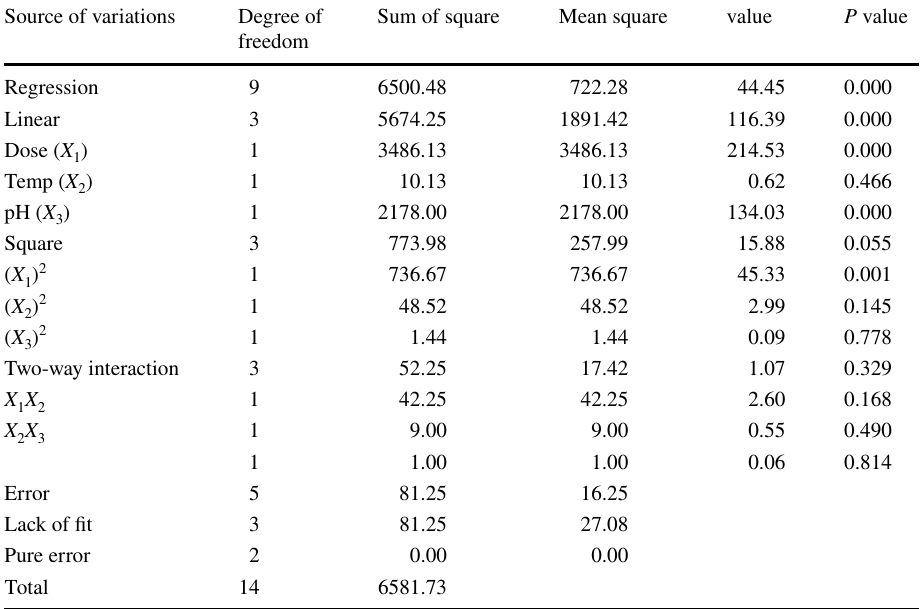
Source of variations